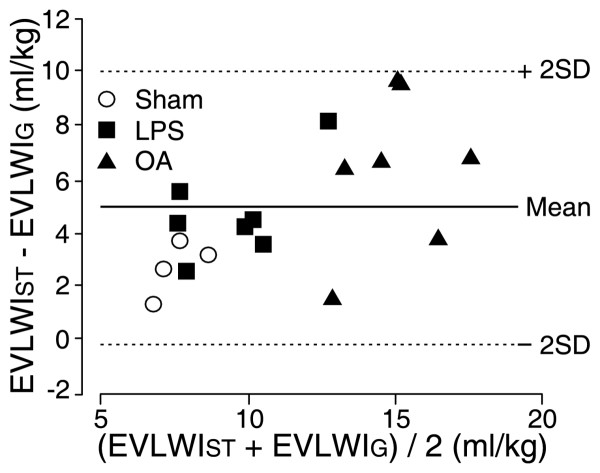
Bland-Altman plot for the extravascular lung water index (EVLWI) measured using transpulmonary single thermodilution (EVLWIST) and postmortem gravimetry (EVLWIG) in sheep. The x-axis shows the mean of EVLWI measurements by single thermodilution and gravimetry. The y-axis shows the difference between the methods. The bold line indicates the value for the mean difference between EVLWIST and EVLWIG (bias), and each dashed line indicates two standard deviations (SDs). Mean difference EVLWIST - EVLWIG = 4.91 ml/kg (SD 2.54 ml/kg).